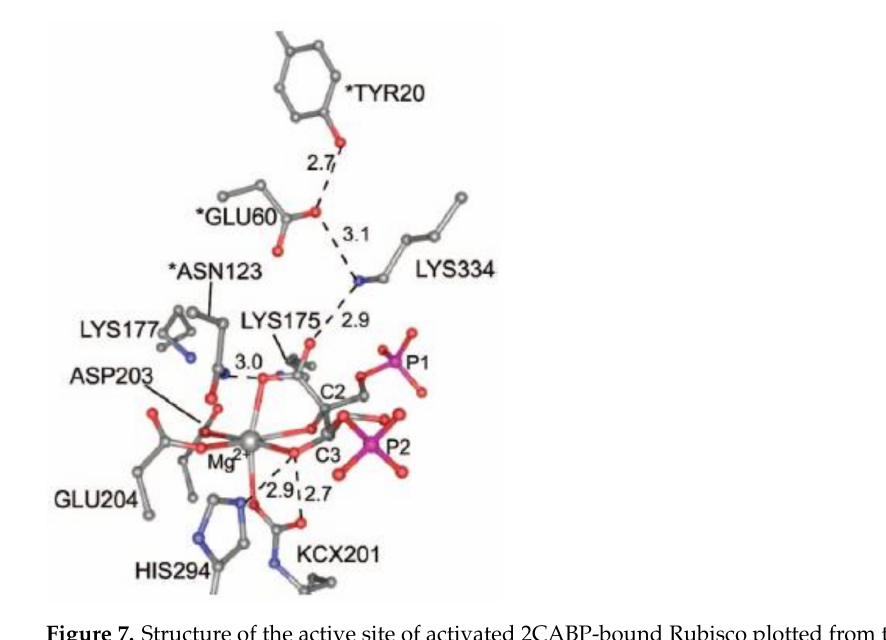
Figure 7. Structure of the active site of activated 2CABP-bound Rubisco plotted from the 8RUC.PDB file (Protein Data Bank) showing the coordination environment of Mg 2+ as proposed by Gready et al., in 2008. Residues with an asterisk in the label are from N-terminal domain of the antiparallel L subunit. Numbering of amino acid residues is based on that of spinach Rubisco (Figure from ref. [37], adapted and used by permission of American Chemical Society (copyright ©